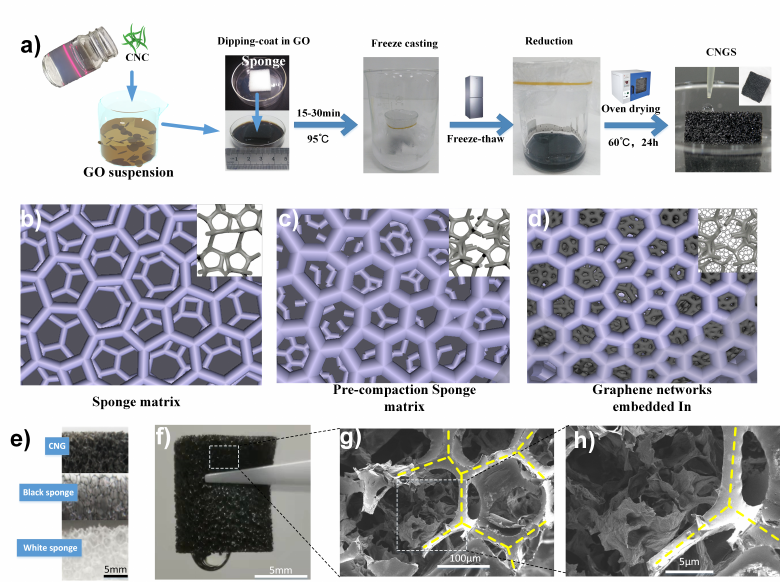
Figure 1. ( a ) Illustration of the preparing process of CNGs at ambient pressure condition. ( b – d ) the proposed schematic sketch for explaining the precompression and formation process of the cellular structure embedded in CNGs; ( e – f ) Digital images of CNG from macroscopic porous; ( g – h ) SEM images of porous